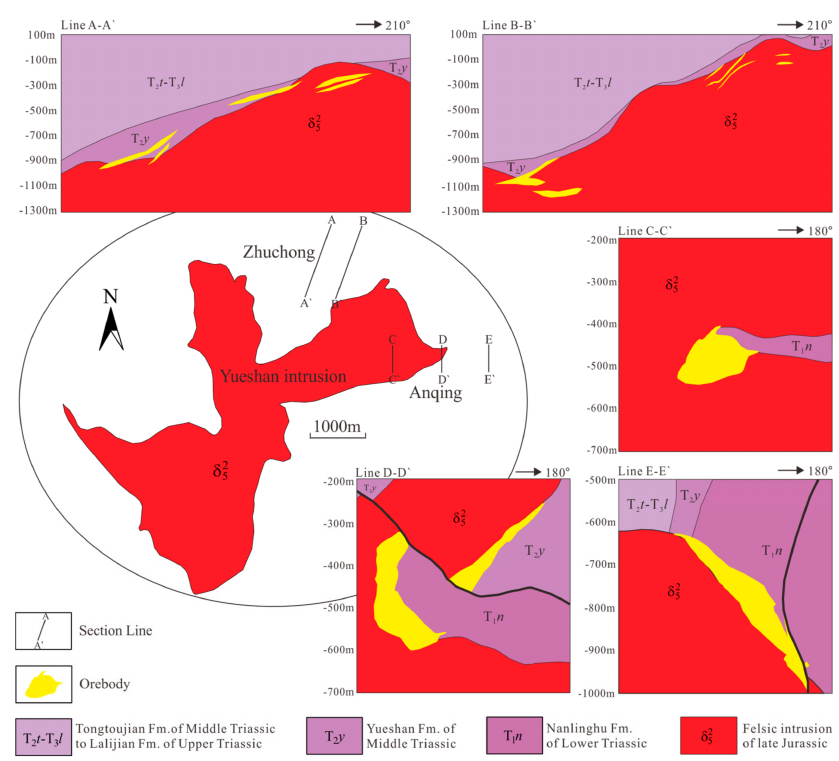
Figure 2. Serious cross sections, showing the correction of orebodies with intrusion and strata. Line A–A (cid:48) and B–B (cid:48) for the Zhuchong ore deposit, Line C–C (cid:48) , D–D (cid:48) , and E–E (cid:48) for the Anqing ore